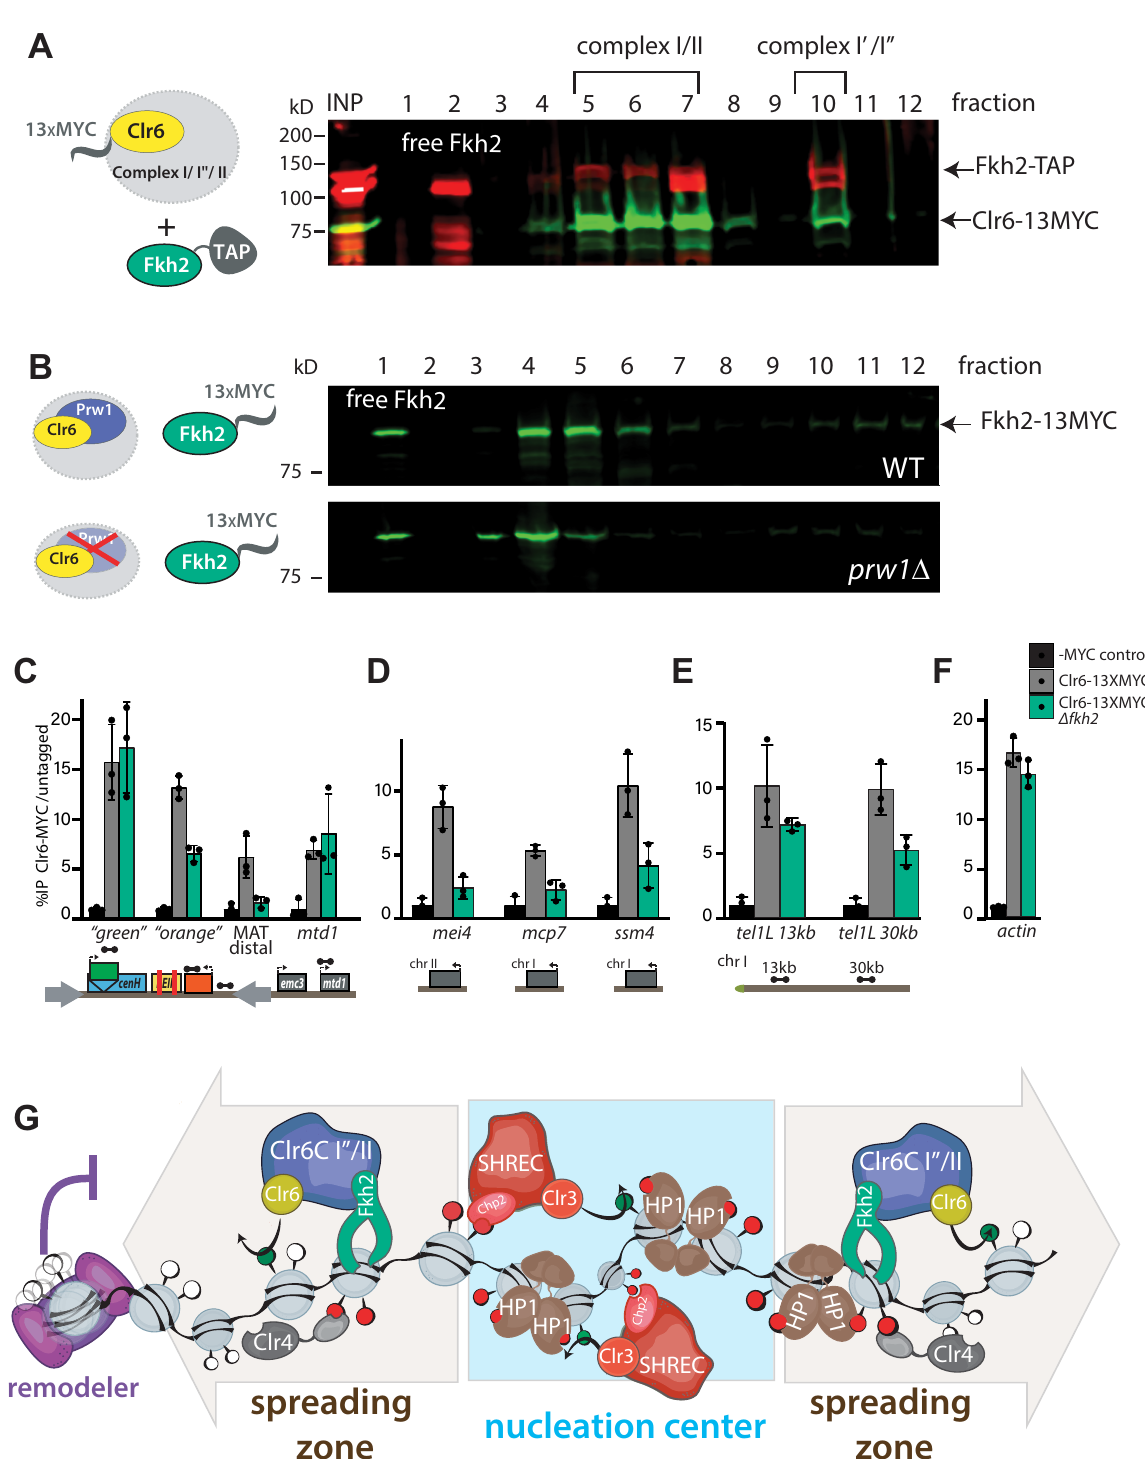
Fig 6. Fkh2 is a resident member of multiple Clr6 complexes and directs Clr6 to nucleation-distal heterochromatin regions. A. Fkh2 co- migrates with medium sized and large Clr6 complexes. Western blot against TAP (red) and MYC (green) on fractions of a sucrose density gradient of whole cells extract containing Fkh2-TAP and Clr6-MYC. Fkh2 migrates as a free protein on top of the gradient and in both major peaks of Clr6. Complex annotation based on [44]. B. Fkh2 migration in sucrose gradients depends on Prw1. Western blot against MYC (green) on fractions of a sucrose density gradient of wild-type (WT) or Δ prw1 whole cell extract containing Fkh2:MYC. While the free Fkh2 fraction